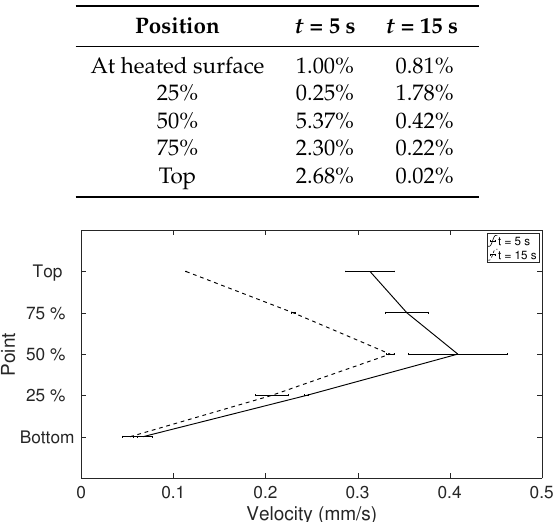
Table 5. The precision error in five points along the symmetry line for t = 5 and 15 s.